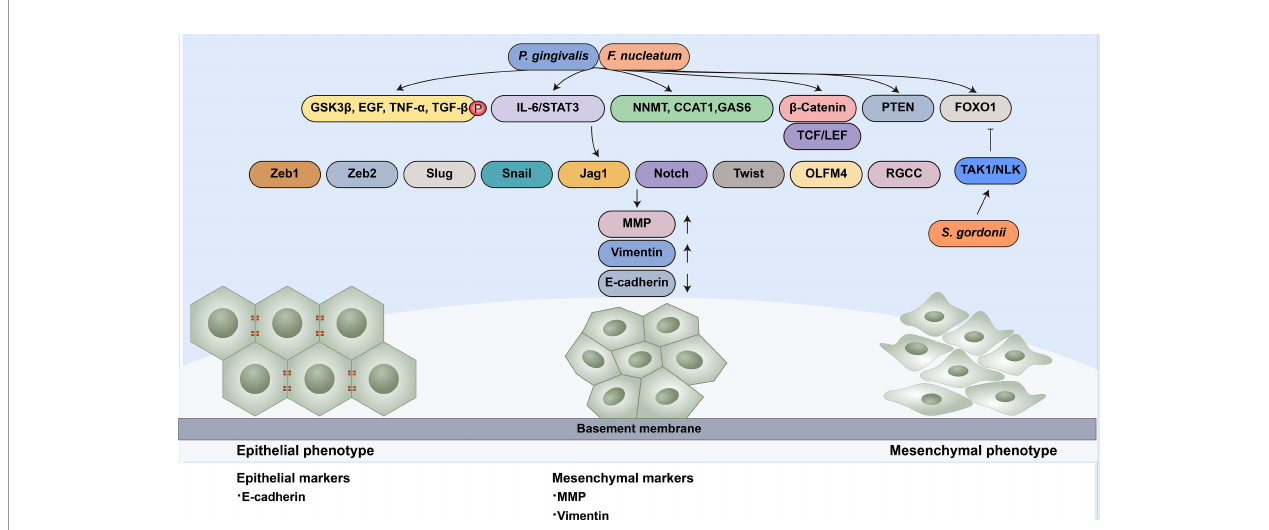
FIGURE 2 | Oral microbiota guide epithelial-mesenchymal transition of normal epithelial cells. EMT-associated transcription factors (Zeb1, Zeb2, Slug, Snail, Jag1, Notch, Twist, OLFM4 and RGCC) can induce epithelial cells to undergo partial or complete mesenchymal transformation by downregulating epithelial markers (such as E-cadherin) and upregulating mesenchymal markers (MMP and Vimentin). P. gingivalis and F. nucleatum enhance the expression of EMT-associated transcription factors through diverse pathways: (1) the phosphorylation of GSK ‐ 3 b , EGF, TNF- a and TGF- b 1; (2) the activation of the IL-6/STAT3 pathway; (3) the upregulation of NNMT, CCAT1 and GAS6;(4) the nuclear translocation of b -catenin and further activation TCF/LEF promoter elements; (5) the activation of PTEN; and (6) the upregulation of FOXO1 S. gordonii can resist EMT-associated factor induction by P. gingivalis by suppressing FOXO1 and activating the TAK1-NLK negative regulatory